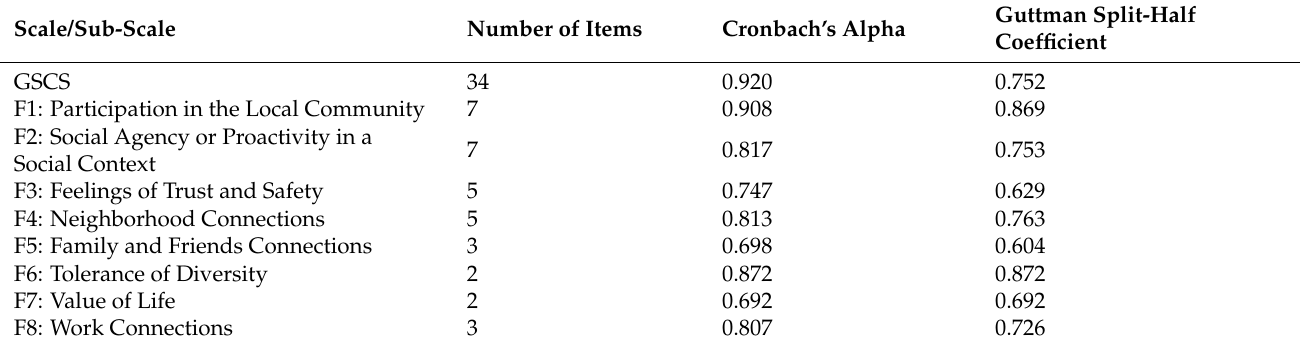
Table 2. The internal consistency reliability and the split-half reliability for the GSCS-Chinese version ( n = 3367).